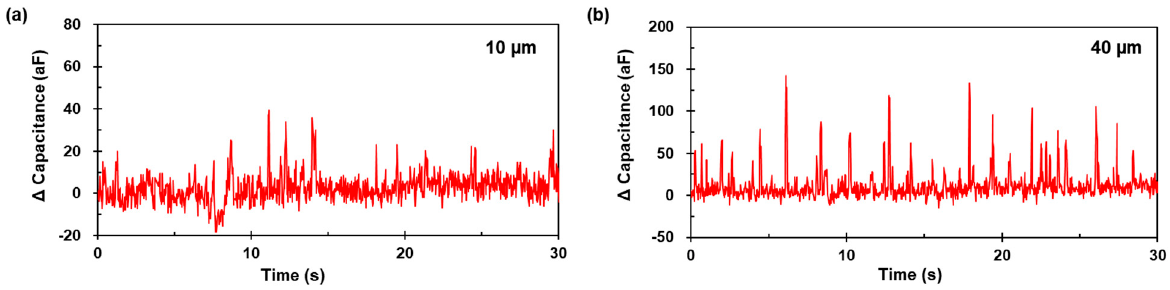
Figure 11. Measured capacitance signals for the aluminum particle sizes in ( a ) d = 10 μ m ( b ) d = 40 μ m at 1.8 MHz.